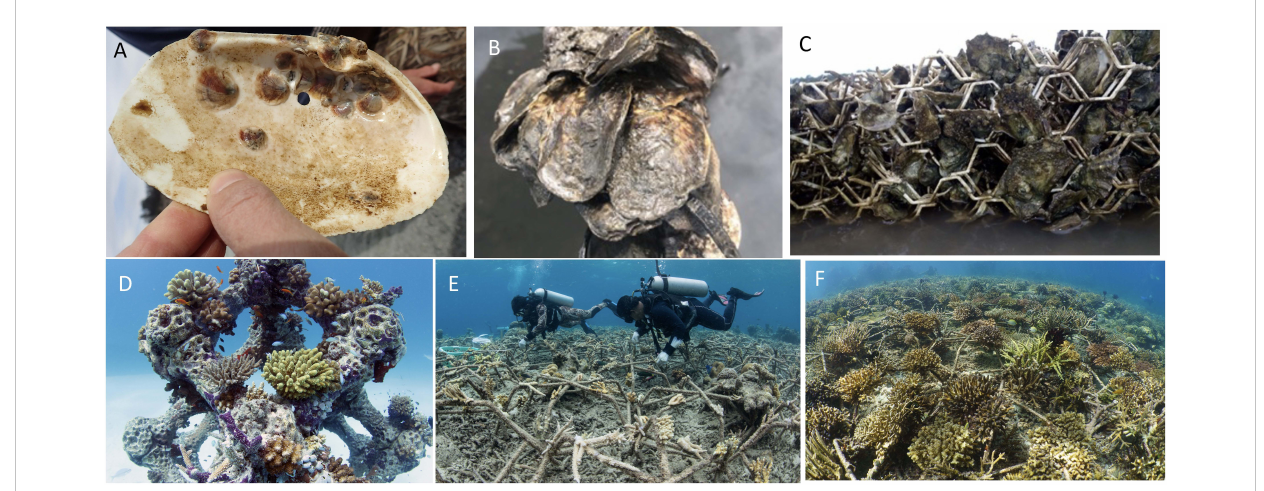
FIGURE 4 Innovative methods for building complex reefs. (A) Hatchery-raised oyster aggregation on clam shell. Photo credit: (C) Zabin; (B) Cluster resulting from aggregation like the one at right one year after deployment. Photo credit: (K) Wasson; (C) Biodegradable framework seeded with cultured oysters jumpstarts reef formation. Photo credit: Nitsch et al., 2021; (D) Interlocking modular units mimic dead coral, and can facilitate the addition of individuals at multiple life stages. Photo credit: (A) Goad, Reef Design Lab. (E) Coated metal “ reef star ” structures with coral fragments attached mimic and stabilize coral rubble, Pictured: Mars, Incorporated divers, with permission. Photo credit: Mars, Incorporated (F) Hard corals grow over the “ reef star ” structures to form a reef, Photo credit: Mars,